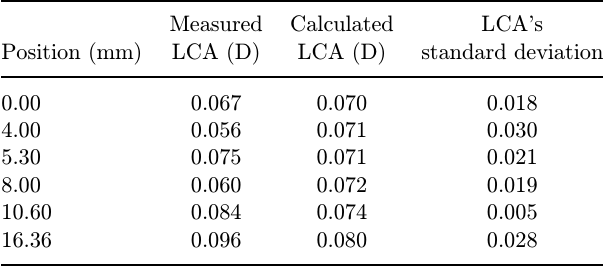
Table 3. Measured and calculated LCA